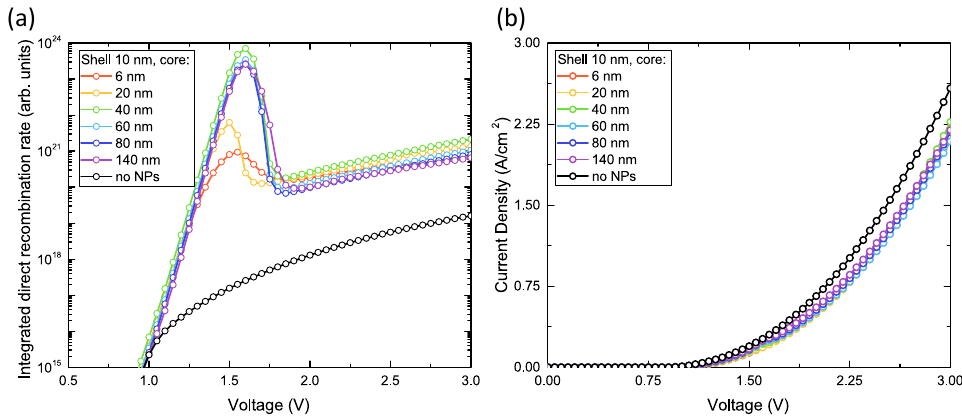
Figure 5. Calculation of optimal core diameter: ( a ) integrated direct recombination rate for single NP ( b ) I–V curves of the device. Shell thickness is fixed and equals 10 nm.